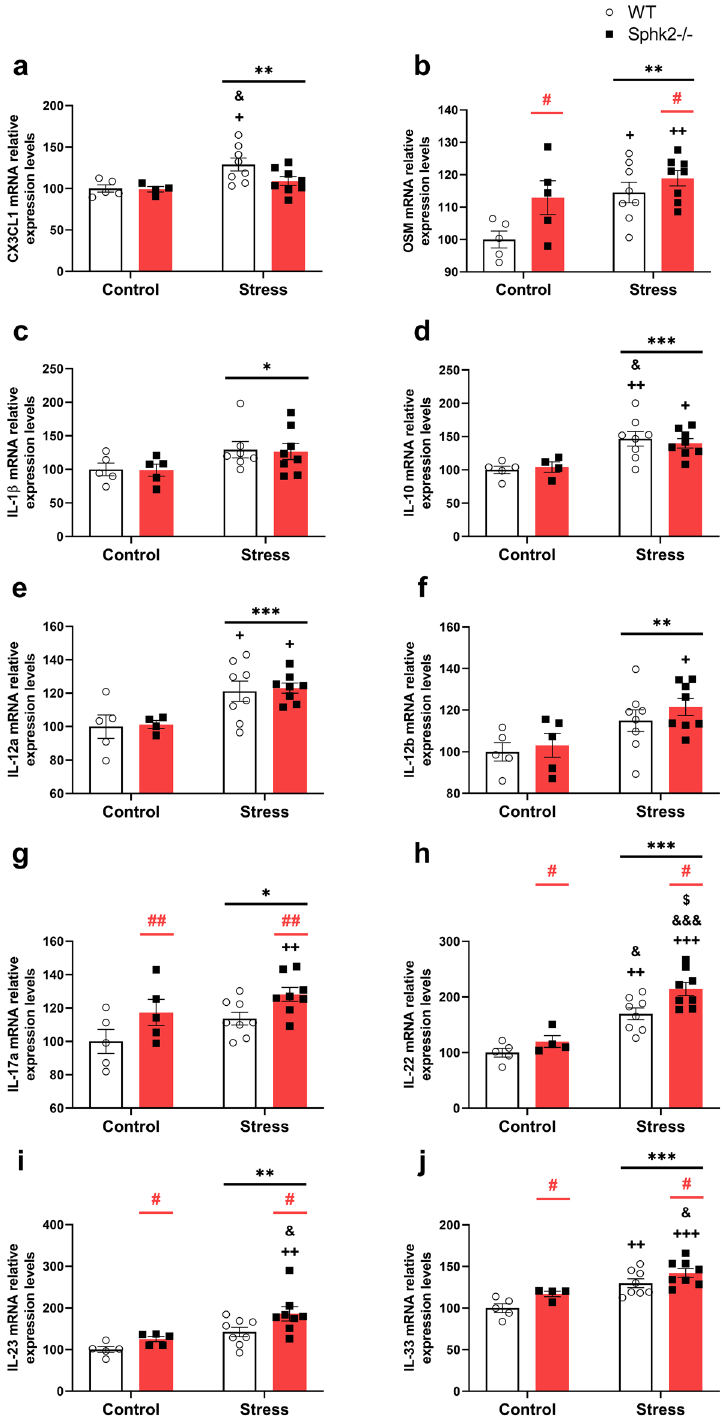
Figure 3. mRNA cytokine expression in the colon of WT and Sphk2−/− mice after sub-chronic stress exposure. mRNA levels of CX3CL1 ( a ), OSM ( b ), IL-1β ( c ) IL-10 ( d ), IL-12a ( e ), IL-12b ( f ), IL-17a ( g ), IL-22 ( h ), IL-23 ( i ), and IL-33 ( j ). Data are means ± SEM of 5–8 mice per group. Two-way ANOVA considering stress (S) and Sphk2−/− as independent variables followed by Tukey’s post hoc; *S p < 0.05, **S p < 0.01, ***S p < 0.001; #Sphk2−/− p < 0.05, ##Sphk2−/− p < 0.01; + p < 0.05, ++ p < 0.01, +++ p < 0.001 vs Control WT; & p < 0.05, &&& p < 0.001 vs Control Sphk2−/−; $ p < 0.05 vs Stress WT. Sphk2: sphingosine kinase 2; WT: wild-type; Sphk2−/−: Sphk2 knockout; CX3CL1: fractalkine; OSM: oncostatin M; IL: